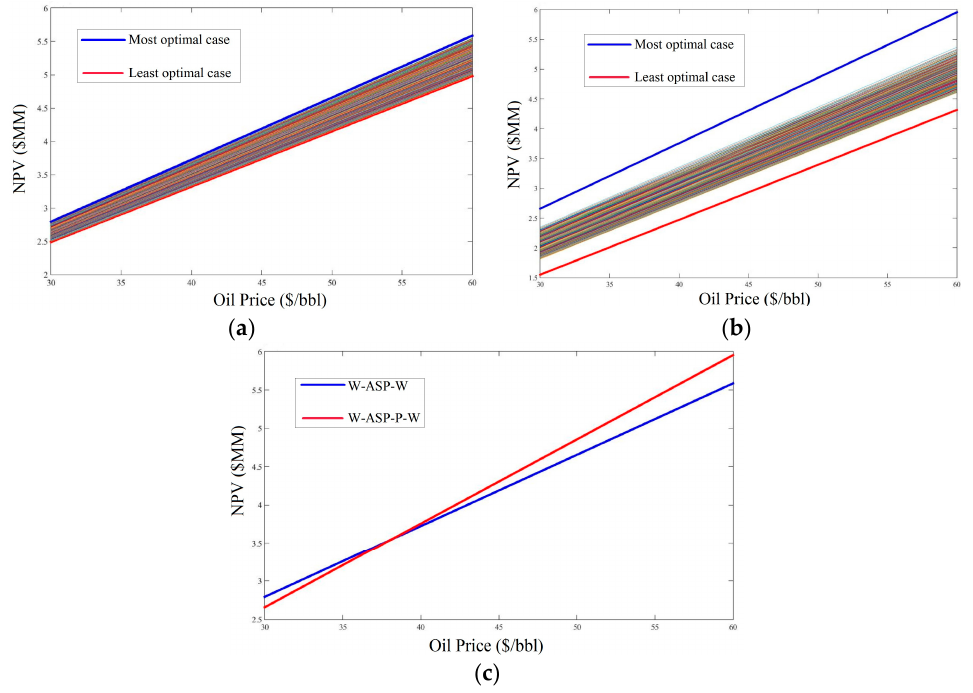
Figure 12. NPVs for various oil prices: ( a ) 1000 estimated cases and the optimal case of W ‐ ASP ‐ W; ( b ) 1000 cases and the optimal case of W ‐ ASP ‐ P ‐ W; ( c ) comparison of the most optimal cases of the two sequences. Table 7. Optimal values of the design variables corresponding to the optimized NPV (wt %).